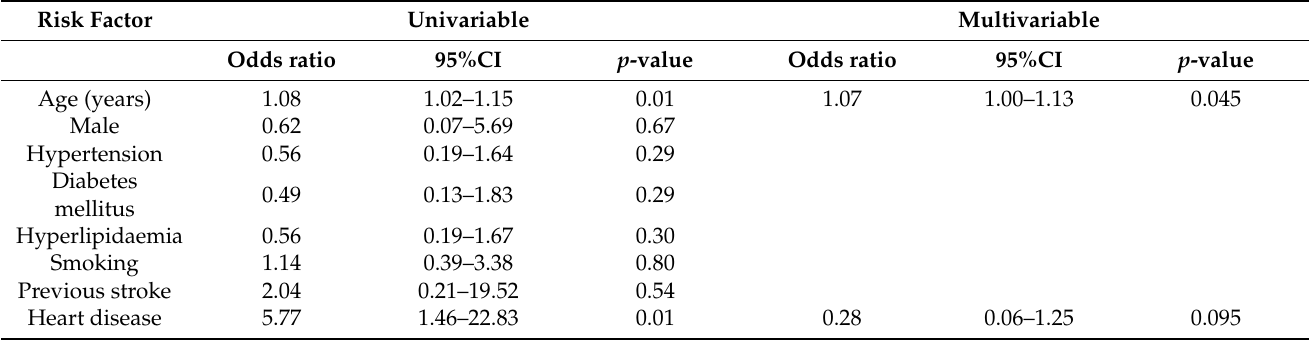
Table 3. Regression analysis of subject risk factors and stroke recurrence.